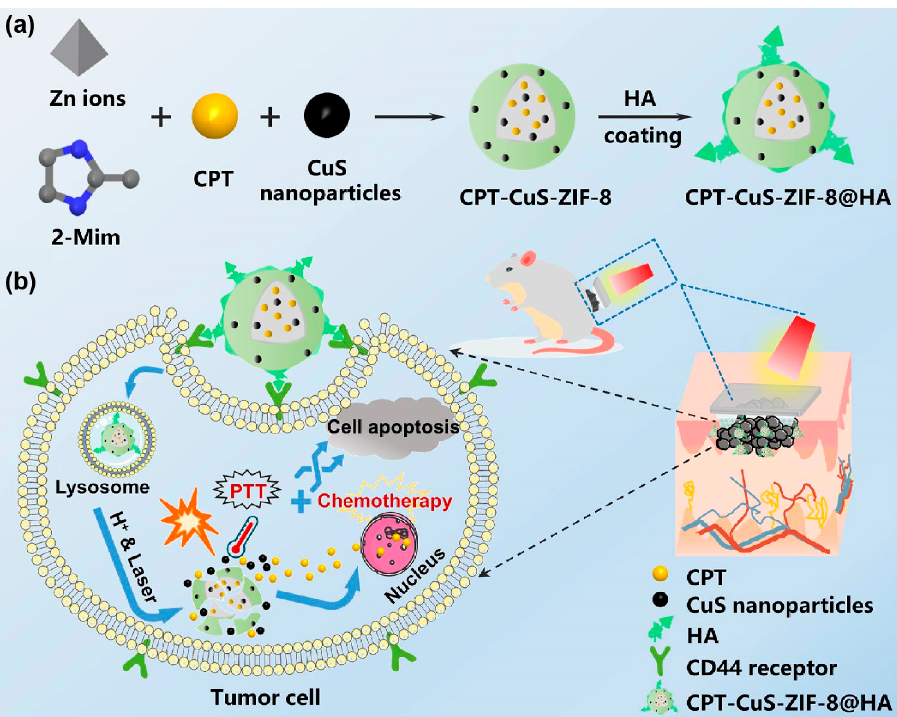
Figure 14. Schematic representation of ( a ) the preparation of CPT-CuS-ZIF-8@HA and ( b ) multifunctional nanoparticle-integrated DMNs for transdermal drug delivery, smart drug release, targeted delivery, and synergistic chemotherapy-photothermal therapy in melanoma [105]. Reproduced with permission from Yiting Zhao, Acta Biomaterialia; published by Elsevier, 2021.